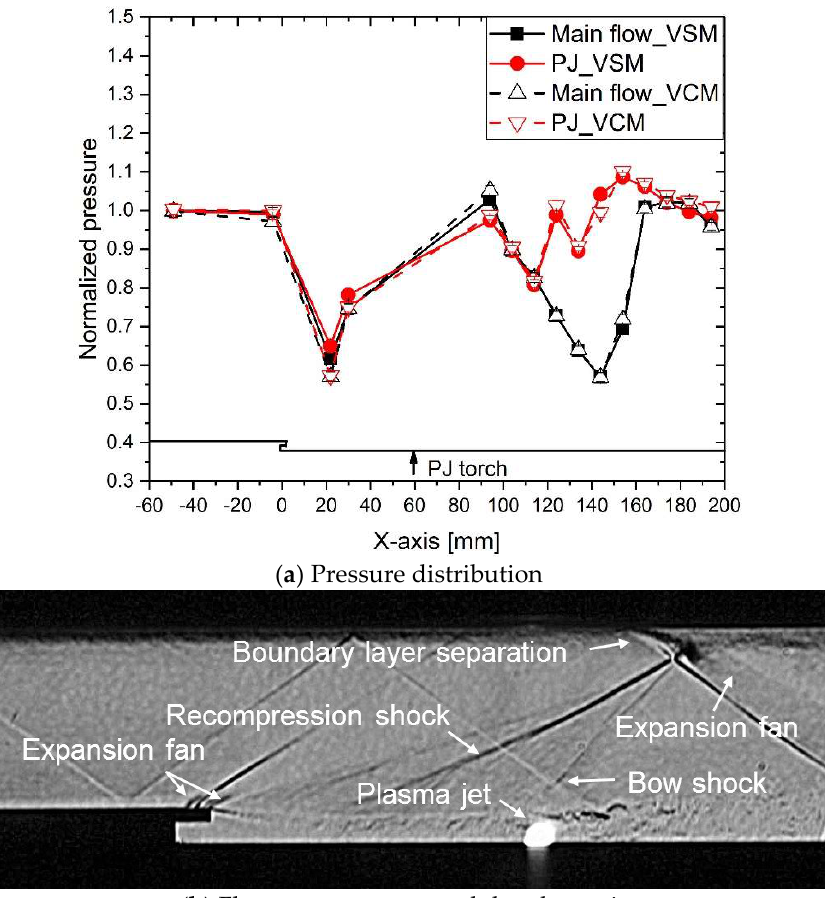
Figure 6. Pressure distribution and flow structure by the effect of the plasma jet: VSM—vent slot mixer, VCM—vent circle mixer, PJ—plasma jet.